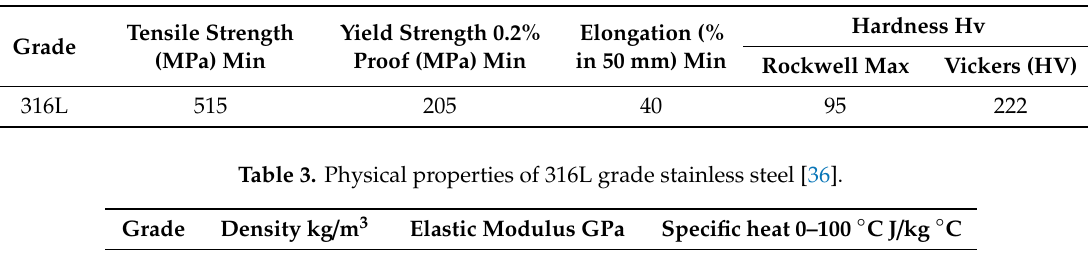
Table 2. Mechanical properties of 316L grade stainless steel [36].